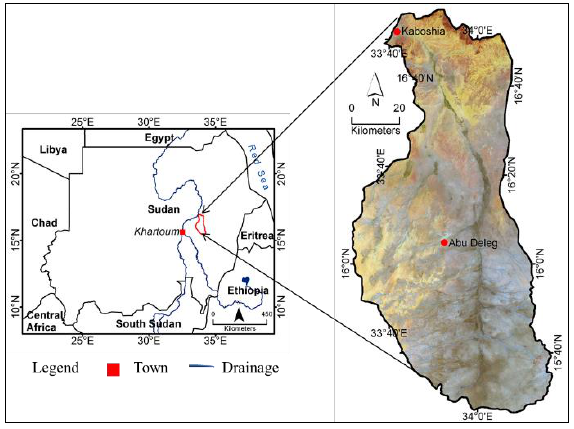
Figure. 1 Location of Wadi El Hawad catchment in the semi-arid region of central